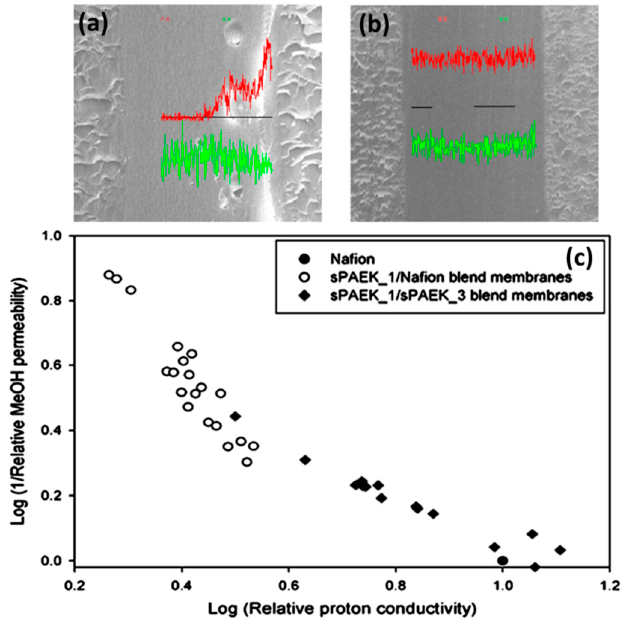
Figure 4. ( a ) Cross-sectional morphology of sPAEK 1:Nafion ® = 2:1 by scanning electron microscopy (SEM) and Energy-dispersive X-ray analysis (EDAX); ( b ) Cross-sectional morphology of sPAEK 1:sPAEK 3 = 2:1 by SEM and EDAX; ( c ) Summary of proton conductivity and methanol permeability of blend membranes. Reproduced with permission from [55]. Copyright Elsevier, 2008.